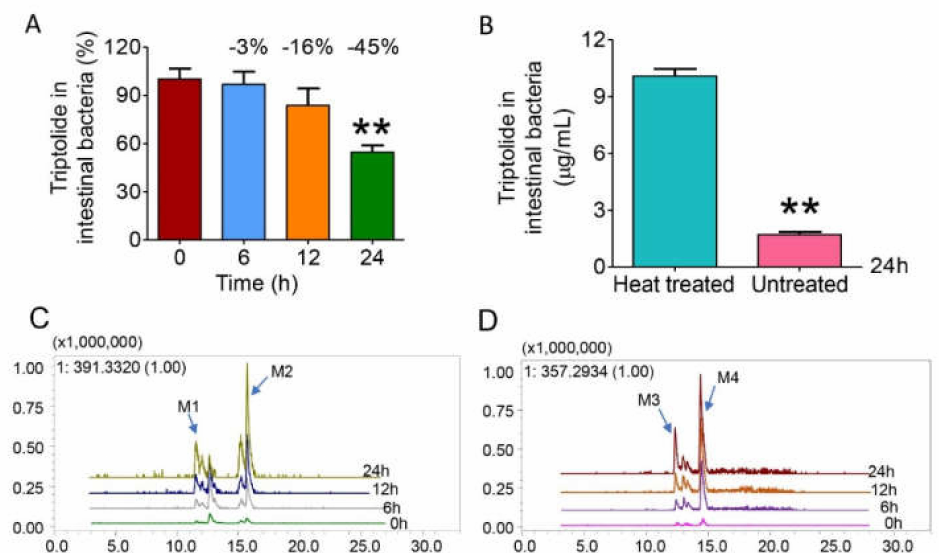
Figure 2. Triptolide could be metabolized in the gut microbiota. ( A ) The level of triptolide decreased during incubation with rat intestinal bacteria after 0 h, 6 h, 12 h, and 24 h. ( B ) Intestinal bacteria mainly participated in the metabolism of triptolide by comparison between untreated and heat-inactivated intestinal contents. ( C ) The extracted ion chromatograms (EICs) showed that the levels of the possible metabolites M1 and M2 increased with increasing time. ( D ) The EICs showed that the levels of possible metabolites M3 and M4 increased with increasing time. Data are presented as mean ± SD, and two-tailed Student’s t test were used for analysis (** p <